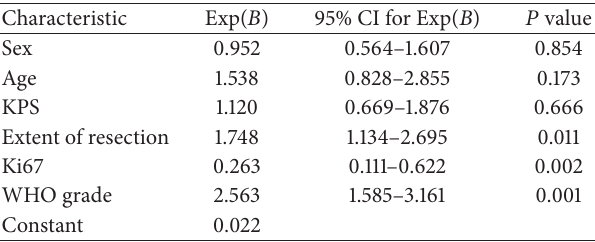
Table 2: Multivariate analysis of the factors related to Girdin